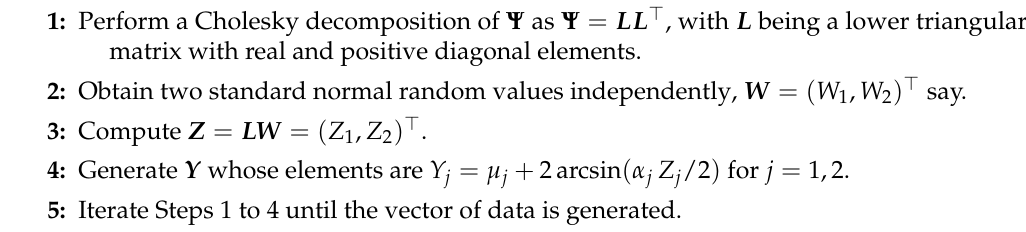
Algorithm 1 Generator of bivariate log-BS random